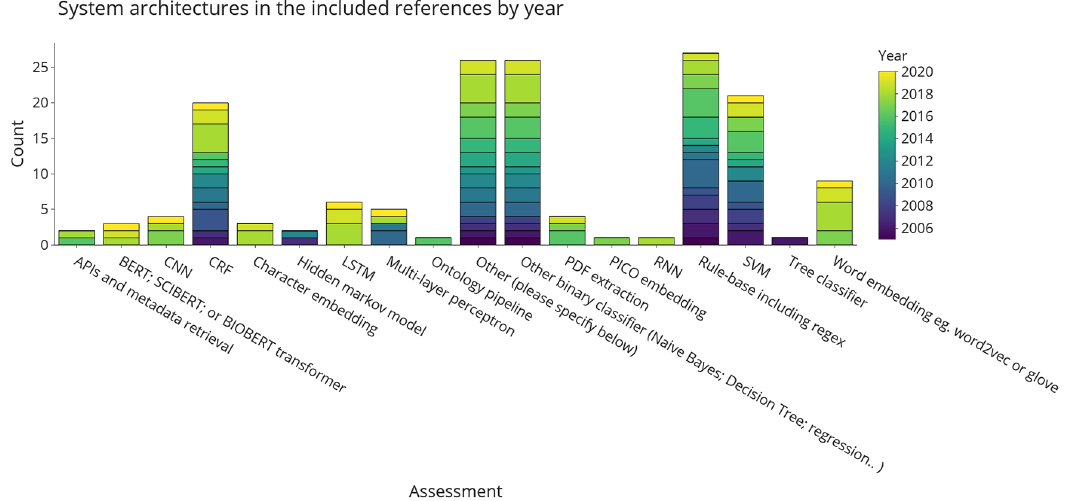
Figure 3. System architectures used for automating data extraction in the included publications. Results are divided into different categories of machine-learning and natural language processing approaches and coloured by the year of publication. More than one architecture component per publication is possible. Where API, application programming interface; BERT, bidirectional encoder representations decision trees; CNN, convolutional neural network; CRF, conditional random fields; LSTM, long short-term memory; PCIO, population, intervention, compar- ison, outcome; RNN, recurrent neural networks; SVM, support vector